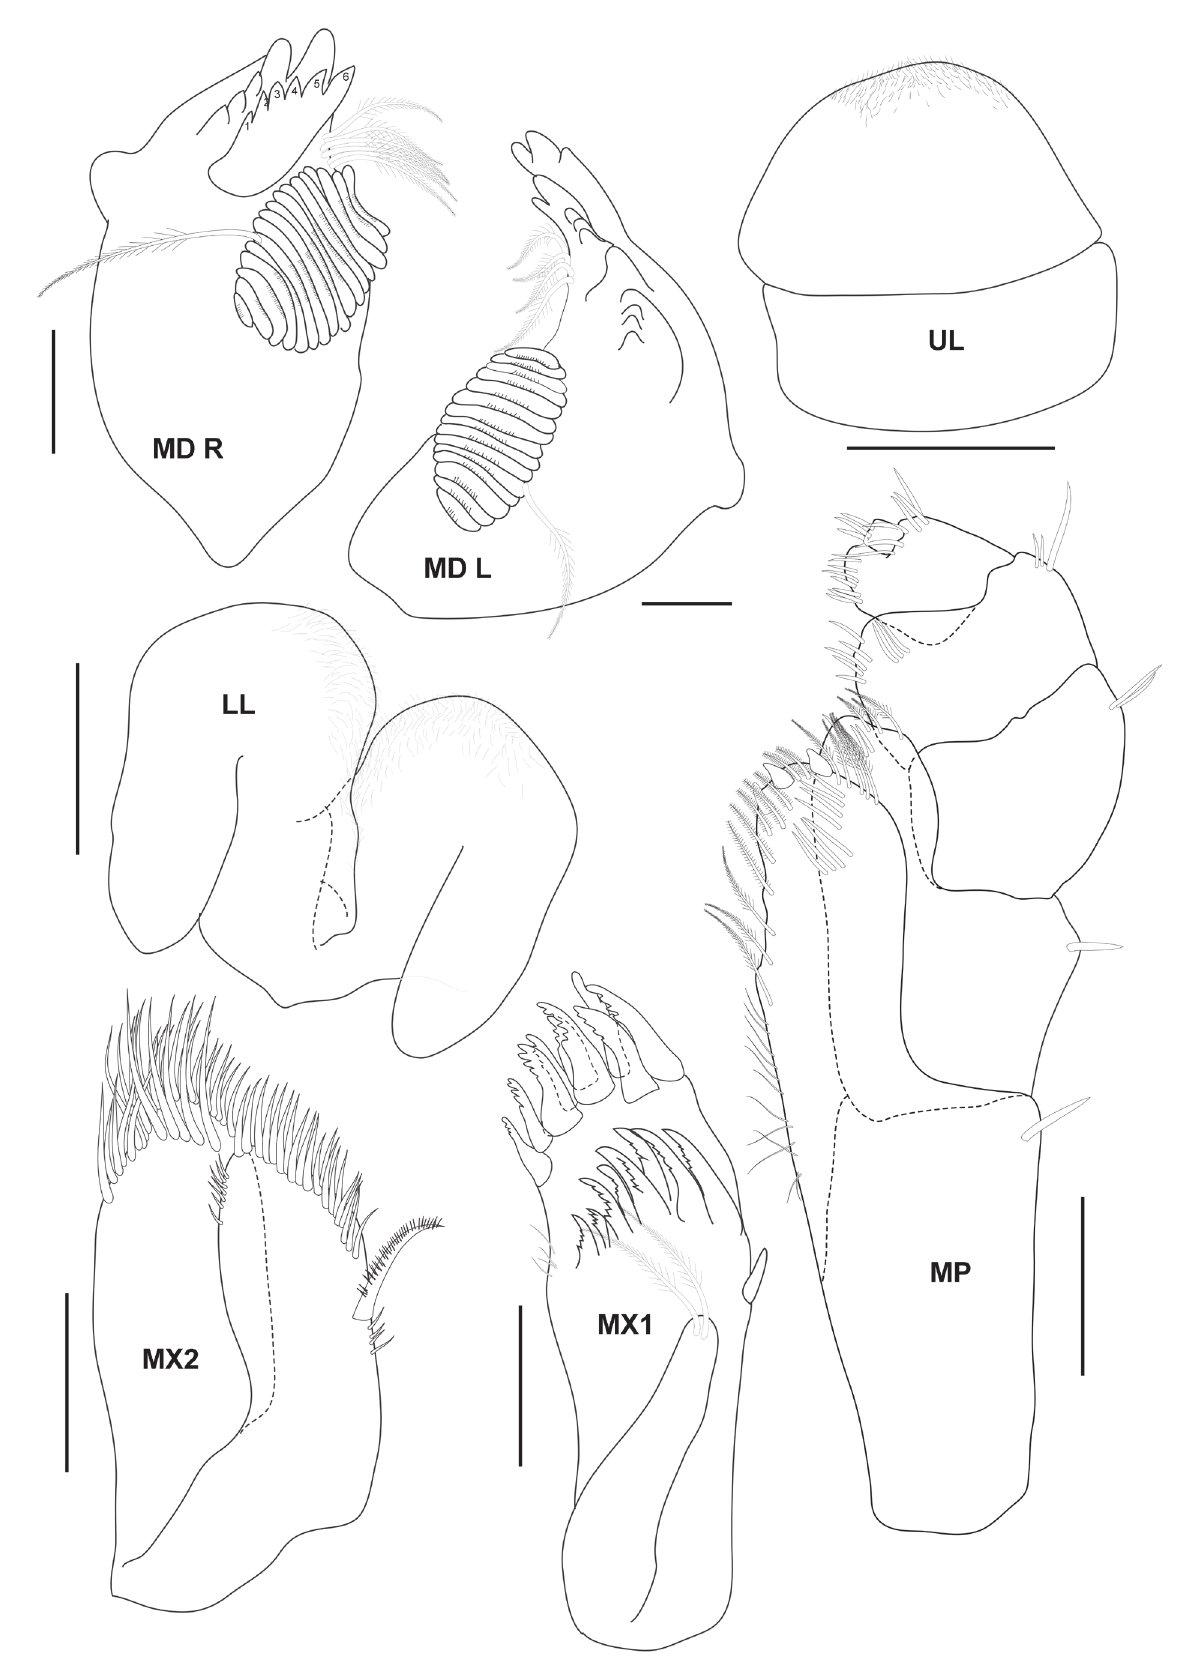
Figure 5. Floresorchestia samroiyodensis sp. n., holotype, female, (PSUZC-CR-0275) 10.6 mm. Khao Sam Roi Yod National Park. Scales for lMD, MX1, MP and MX2 represent 0.1 mm; rMD, UL and LL represent 0.2